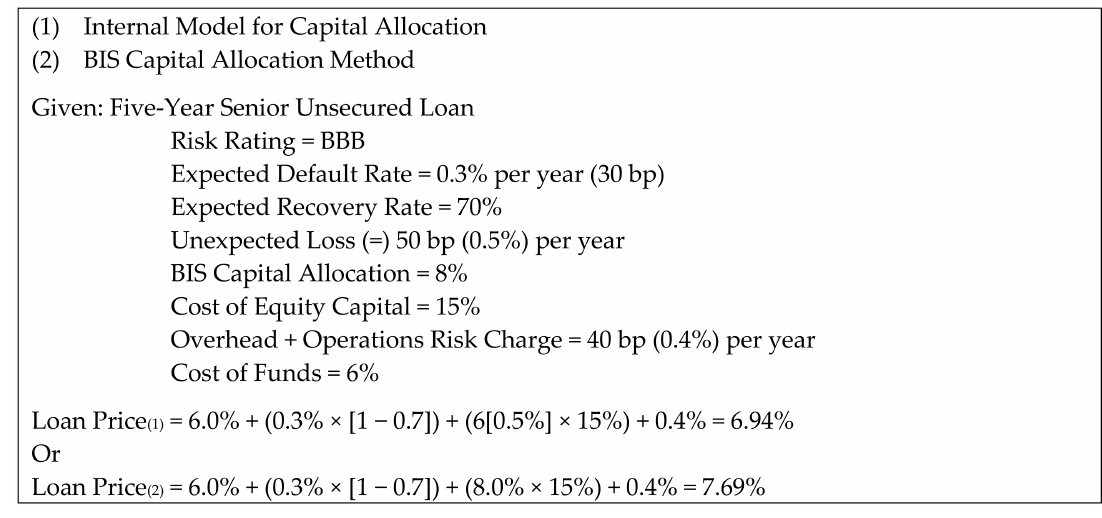
Figure 1. Risk-Based Pricing: An Example. BIS: Bank for International